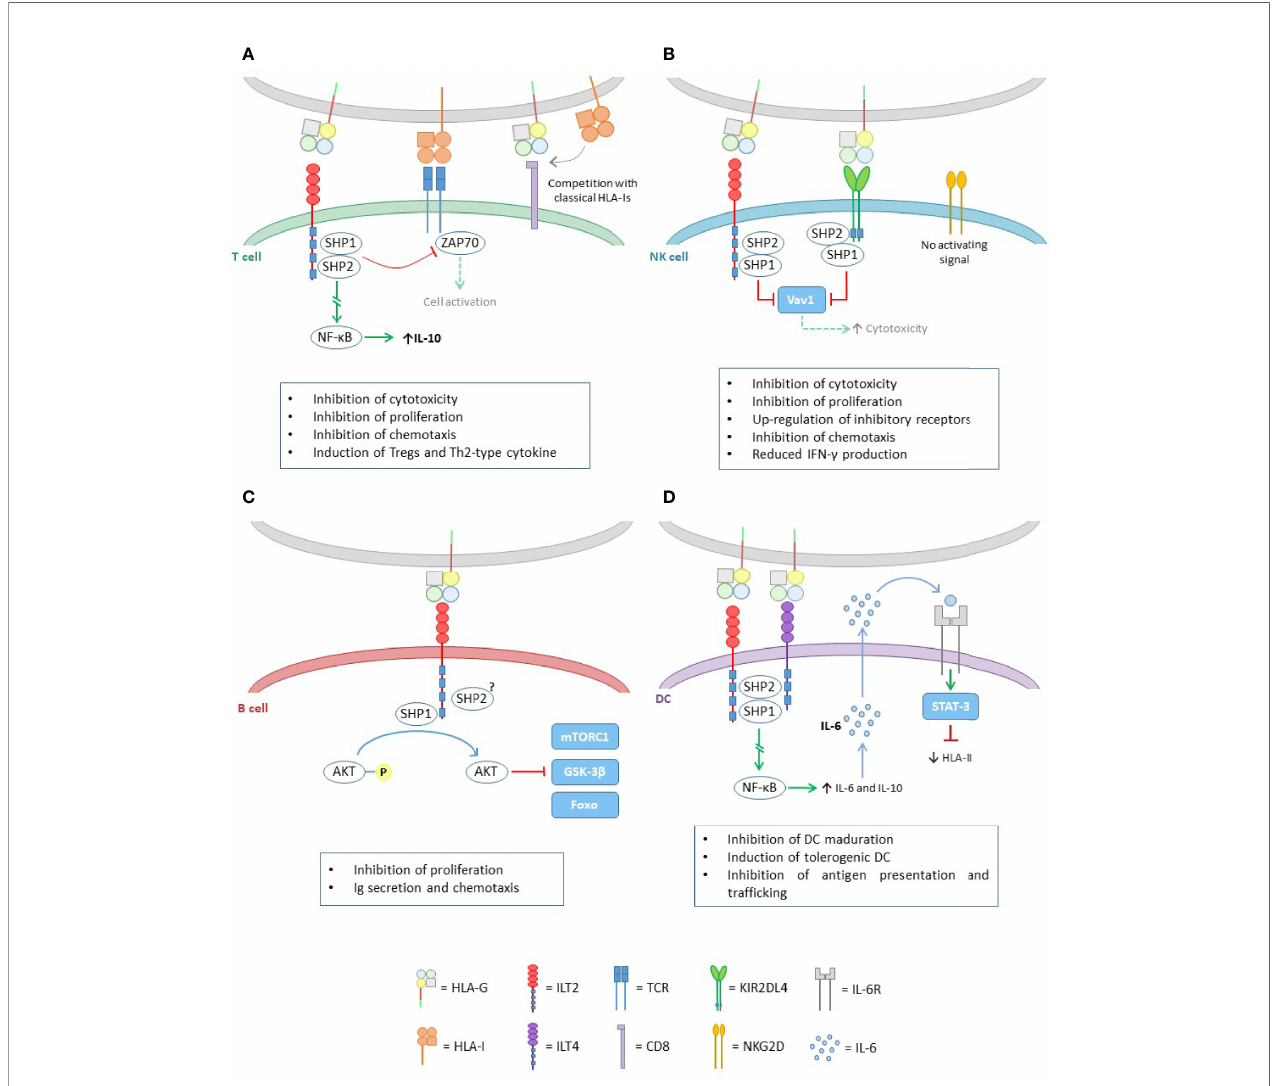
FIGURE 3 | HLA-G effect in the different cells of the immune system. (A) Inhibitory effect of HLA-G on T cells. The binding of HLA-G to ILT2, activates the ITIM domains of the latter and recruits the SHP-1 and SHP-2 phosphatases. On the one hand, these proteins are capable of inhibiting the TCR signal, through ZAP70 dephosphorylation. On the other hand, they trigger a signaling pathway leading to NF-kB activation, which enhances IL-10 expression. HLA-G also exerts its inhibitory function through competition for the union of classical HLA class I molecules to the CD8 coreceptor in CD8+ T cells, and to the TCR. (B) HLA-G binds to its cognate receptors ILT2 and KIR2DL4, both containing inhibitory domains ITIM, which upon activation, recruits SHP-1 and SHP-2, leading to Vav1 inactivation, and thus downregulating the cytotoxicity capacity of NK cells. (C) In B cells, HLA-G works via ILT2, where SHP-1 mainly, is responsible for the dephosphorylation of AKT leading to mTORC1, GSK-3 b and Foxo inactivation. (D) Like in T cells, the pathway initiated by HLA-G through ILT2 and ILT4 leads to NF-kB activation. This factor causes an increase in IL-6 and IL-10 expression. IL-6 is capable of binding to IL-6 receptors on DCs and, through the STAT-3 activation factor, inhibits HLA class II